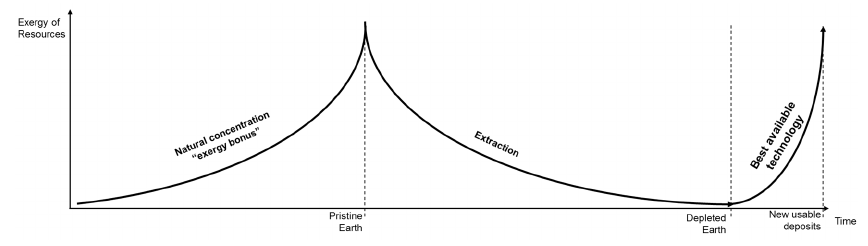
Figure 3. Evolution of the exergy of Earth’s resources.